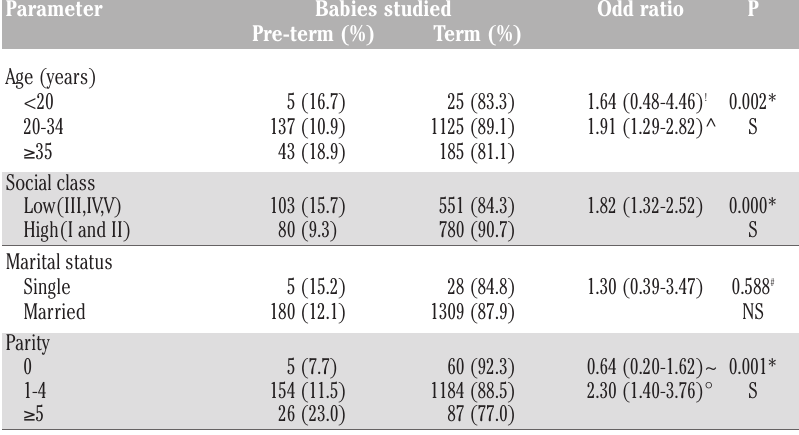
Table 1. Maternal socio-demographic characteristics vs pre-term delivery. Parameter Babies studied